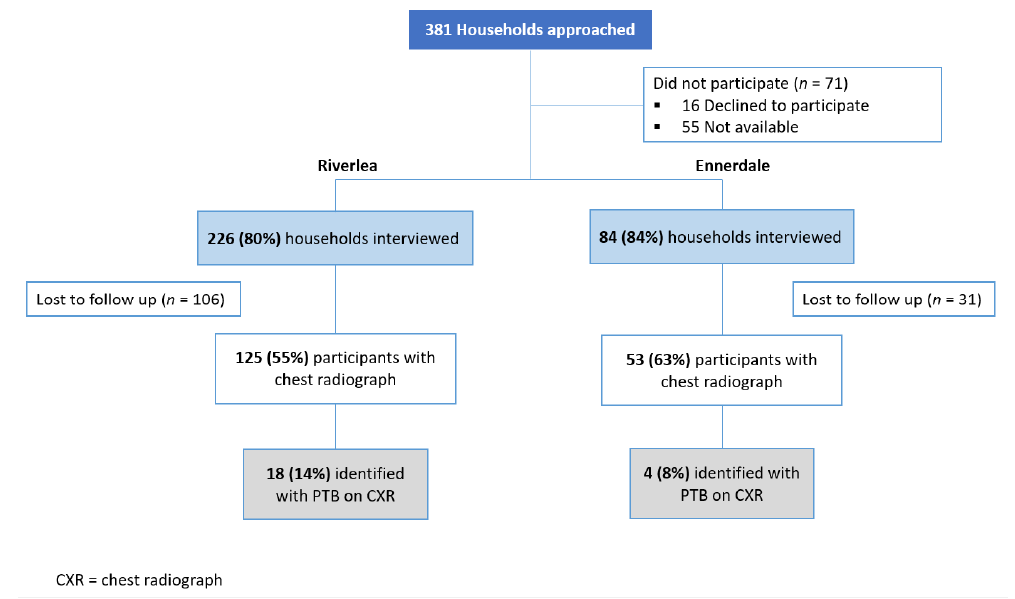
Figure 2. Flow chart describing study recruitment and enrolment.